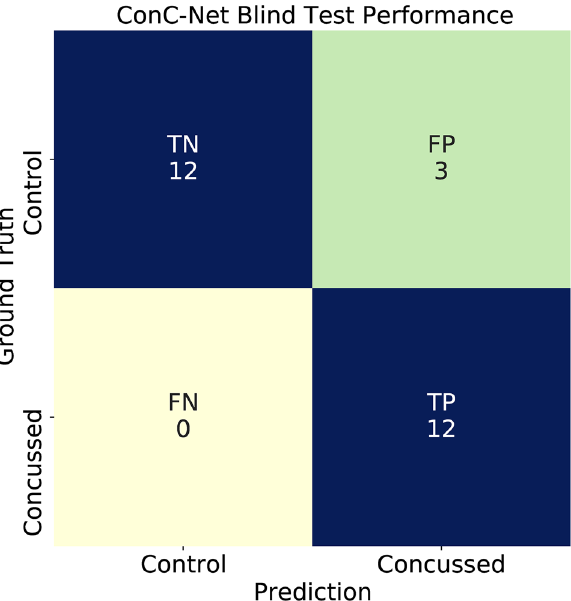
Figure 2. Confusion Matrix summarizing the results from the second test carried out in Stage 1, using 27 raw90-rsEEG samples drawn randomly from the 8 concussed and 10 control participants whose data had been reserved for this purpose. ( Plotted with Matplotlib v3.2.1 75